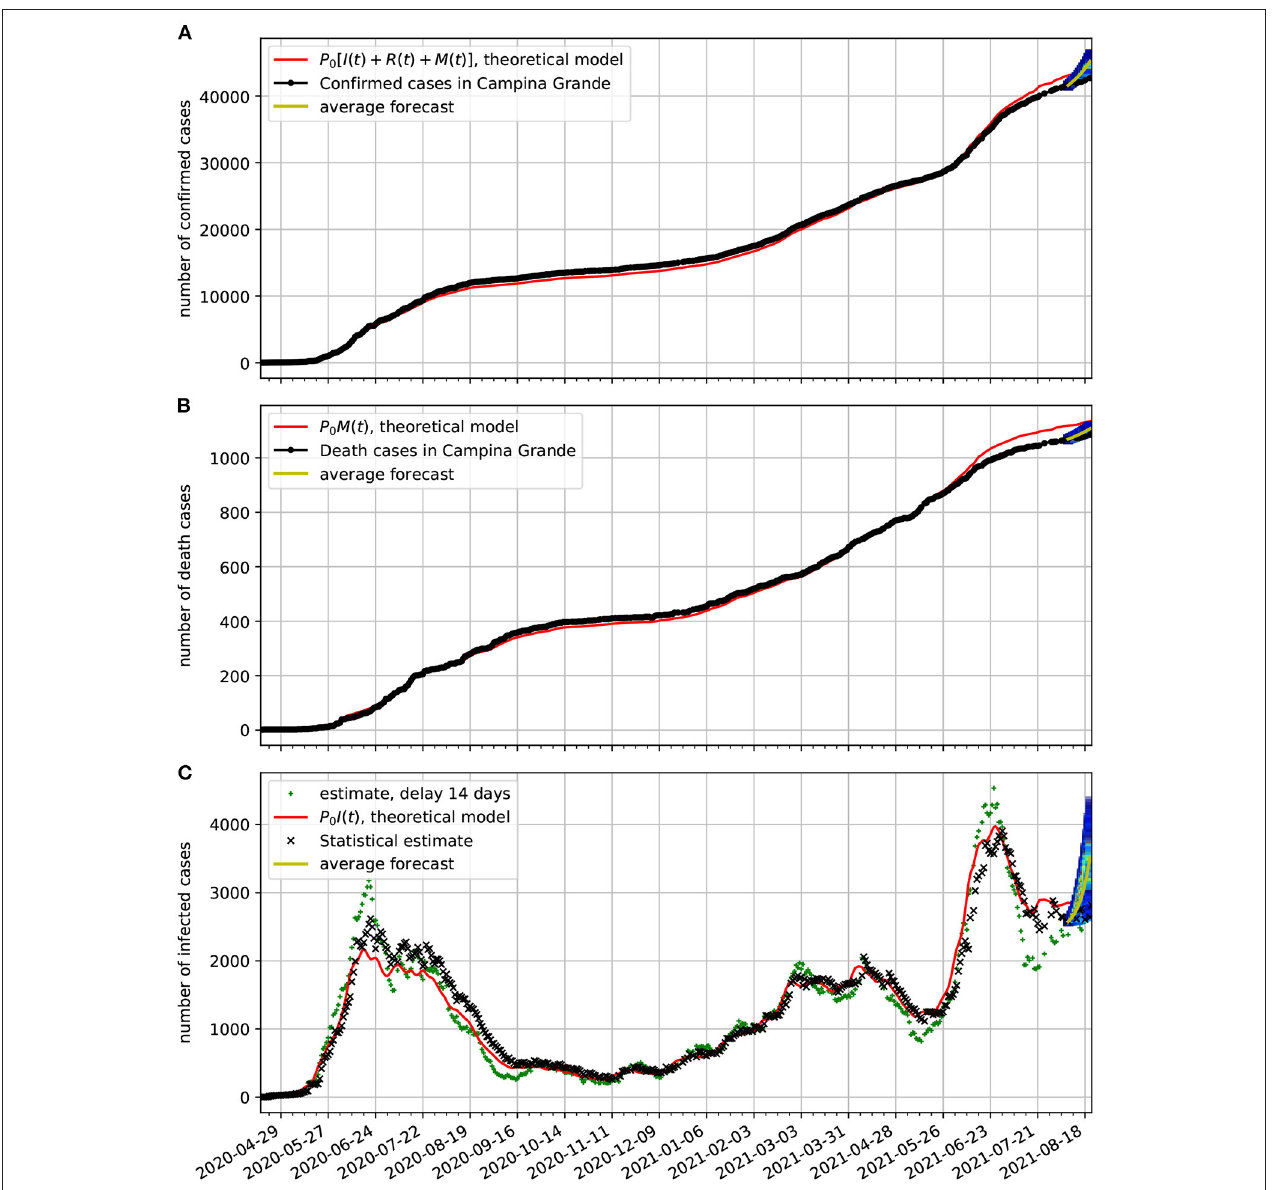
FIGURE 10 | Comparison of epidemiological data from Campina Grande with the theoretical fit based on our model. Also shown near the end of the time series are the statistical forecasting 95% confidence intervals, as described in Section 3.5. In all cases, we used τ Comparison of the number of official confirmed cases with the theoretical fit. (B) Comparison of the number of official deaths due to COVID-19 infection with the theoretical fit. (C) Comparison of the number of the estimated number of active cases with the theoretical